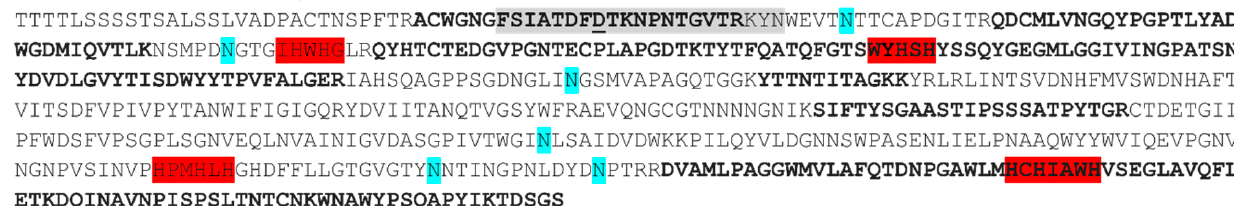
Figure 2. The amino acid sequence of the Bcl1 laccase. The peptides detected by the MS/MS are marked in bold; the amino acids involved in the coordination sites for copper of the type 1, 2 and 3 are highlighted in red; putative Asn-Xaa-Ser/Thr glycosylation sites are highlighted in blue; and the peptide of a flexible loop, homologous to the Sclerotinia sclerotiorum laccase motif containing Y65 [29], that is involved in binding of phenolic compounds, is highlighted in grey (the corresponding amino acid residue D132 in Bcl1 is underlined).